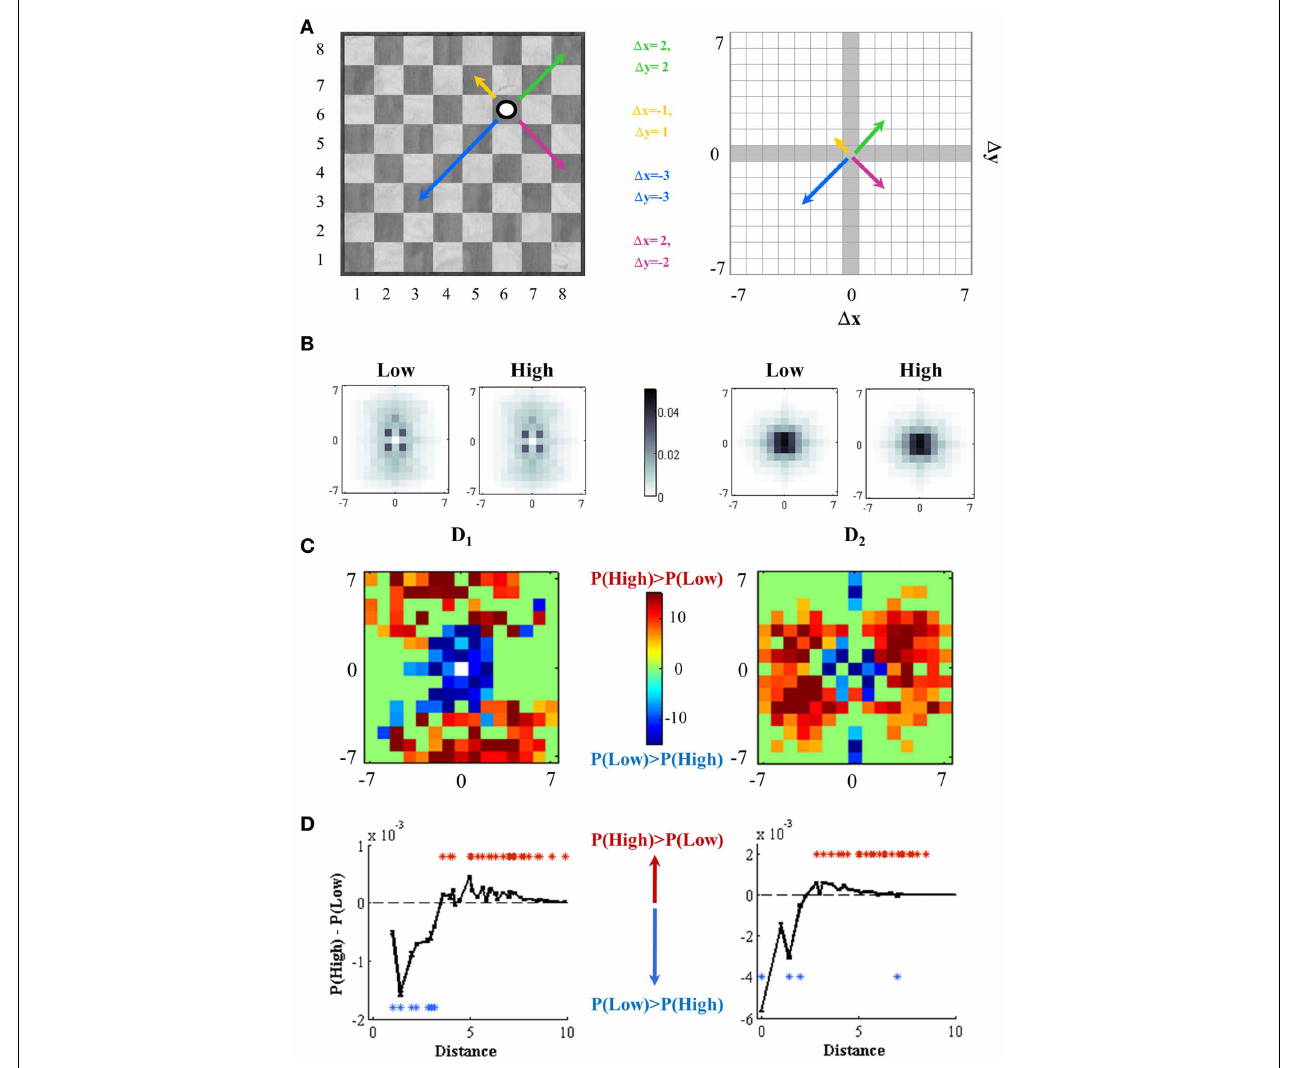
the previous one is higher at short distances, for both High and Low expertise levels. (C) Weak players made their movements closer to the previous one. We contrasted probability distributions for both High and Low rated players on each entry of the 15 ∗ 15 distance square independently. t -value of each independent two-sample t -test (with p -value < 0.001, Bonferroni corrected for multiple comparisons) is color-coded. Positive (red) t -values indicate significantly higher probabilities for high rated players and negative (blue) values, for weaker players. (D) Radial or Euclidean distances. Distances were one-dimension collapsed and the difference between probabilities of making movements corresponding to a distance square [P ( High ) – P ( Low ) ] was plotted vs. each radial distance. High and low rated groups distributions were independently compared in each radial distance [two-sample t -test on each variable (D 1 and D 2 )]. Red asterisks ( t > 5 . 3 for D 1 and t > 5 . 6 for D 2 ) indicates distances were P ( High ) is significantly higher than P ( Low ) ; blue asterisks ( t < − 12 . 3 for D 1 and t < − 11 for D 2 ), distances were P ( Low ) > P ( High ) ; in both p < 0 . 001, Bonferroni corrected for multiple comparisons. Dotted lines indicate distance values where the significances changes from weak to strong